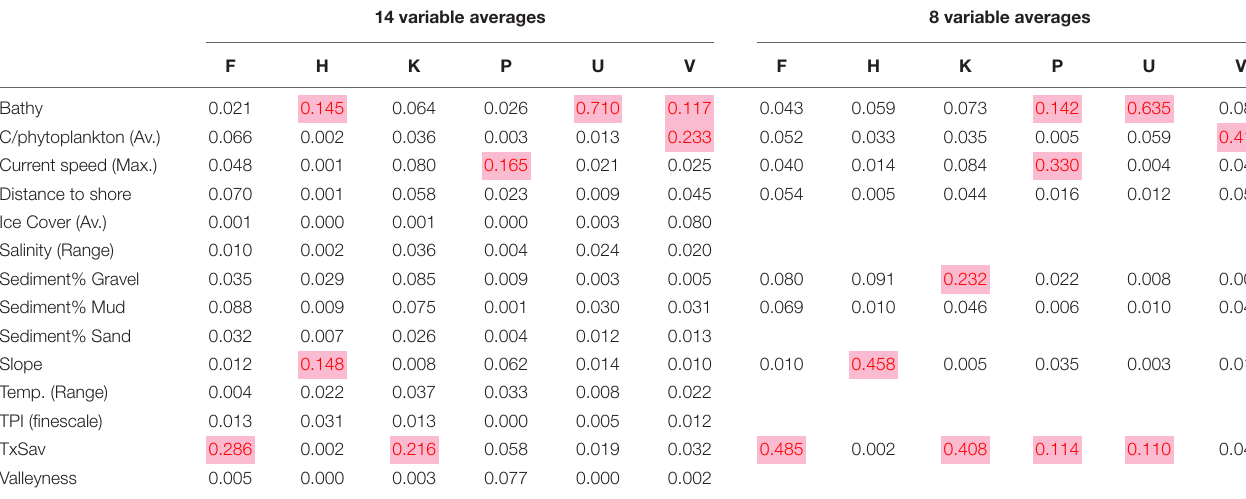
TABLE 4 | Average permuted variable importance from ensemble models per taxon for both the 14 variable and 8 variable ensemble models. 14 variable